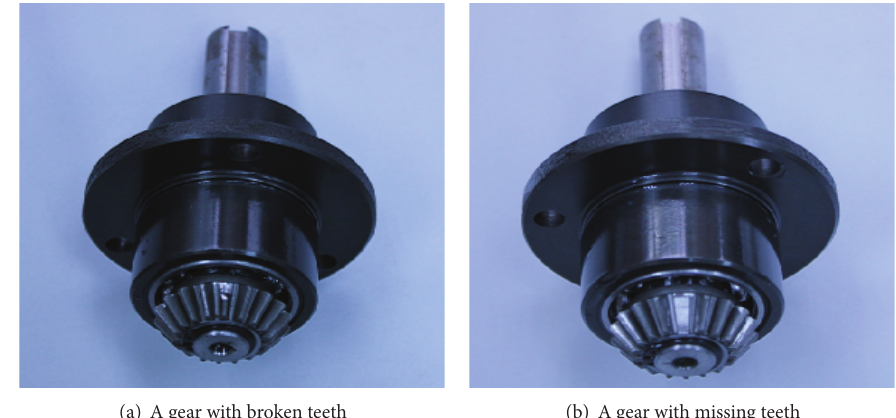
Figure 10: Typical fault gear.